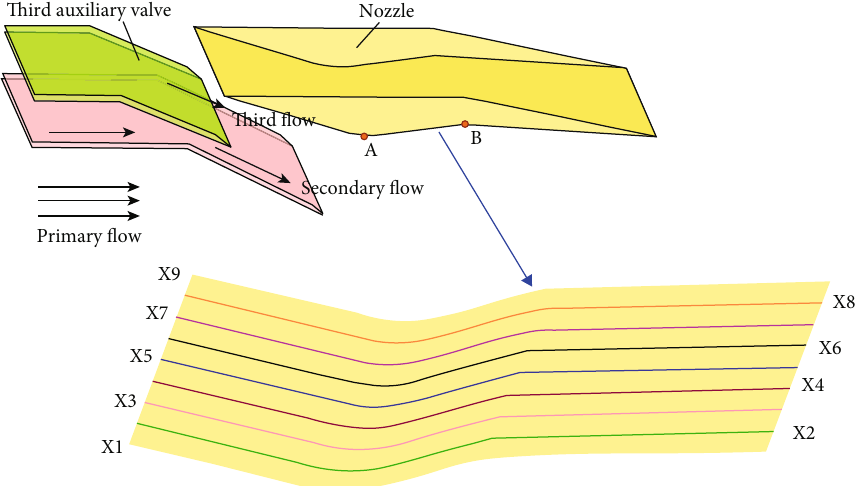
Figure 8: Position of the pressure monitoring curves along the tail